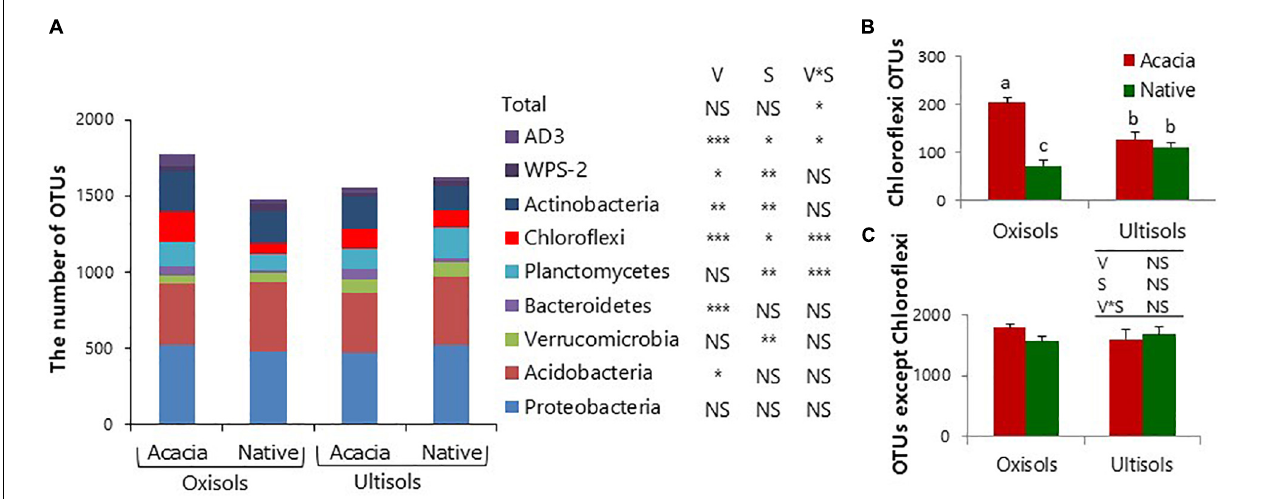
FIGURE 2 | Number of (A) total bacterial OTUs, (B) Chloroflexi OTUs, and (C) OTUs after removing Chloroflexi OTUs for surface soil. Bars show standard deviations of the means. NS, *, **, and *** in inserted tables indicate not significant, P < 0.05, P < 0.01, and P < 0.001, respectively, by two-way ANOVA, V and S indicate Vegetation and Soil types. Different letters indicate significant differences ( P < 0.05).